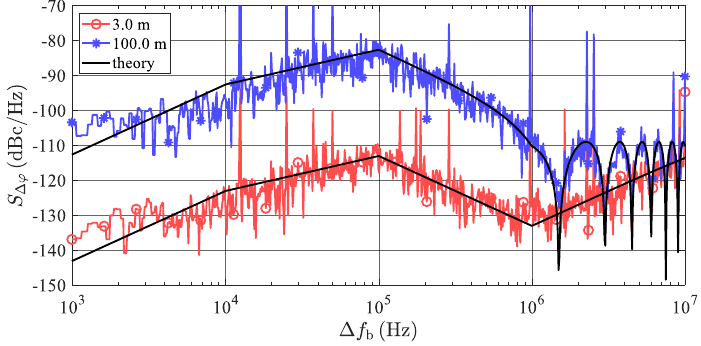
Figure 13. Simulation of phase noise at the radar BB output for targets at ranges of 3 and 100 m producing beat frequencies ( f b ) equal to 150 kHz and 5 MHz, respectively. The frequency axis of Δ f b represents only the positive offset from the corresponding beat frequency. The spikes repeating every 1/Tsw = 12.5 kHz are caused by periodic discontinuities in beat signals at the start of every frequency chirp. The theoretical dependency of phase noise was computed using Equation (27).